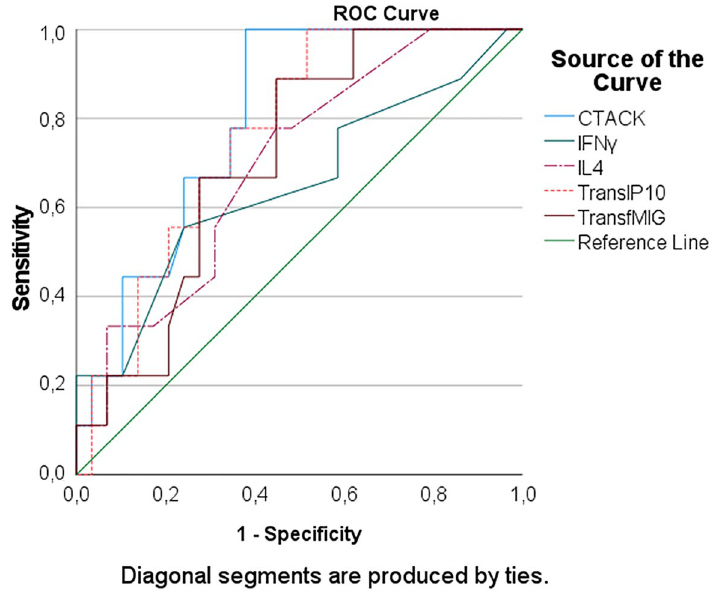
Figure 2. ROC curve of clustering analysis of cytokines that may distinguish MD patients with hypertension from these without hypertension.